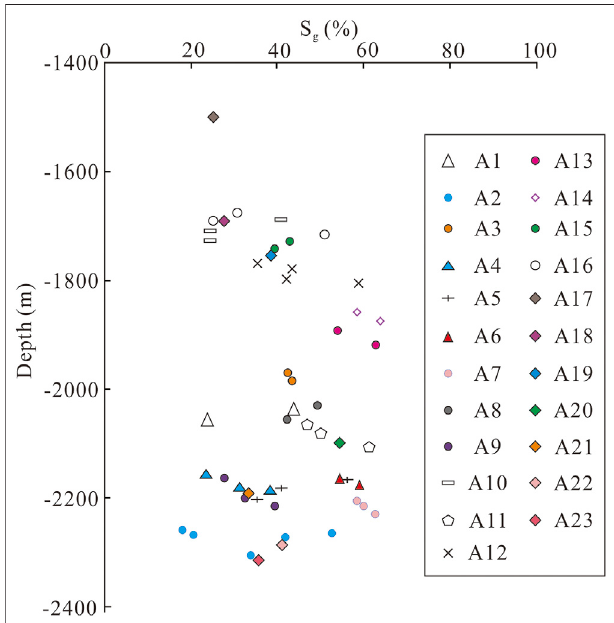
FIGURE 2 | Distribution of gas saturation of sealing coring with depth in He8 Member of